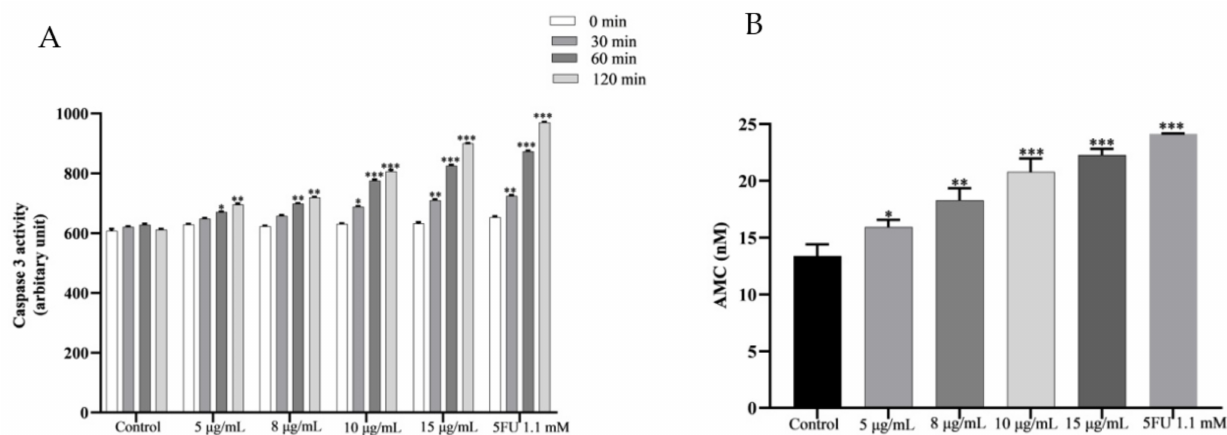
Figure 7. HCT-116 cells treated with PPE (5–15 µ g/mL) and 5FU 1.1 mM for 24 h were assayed for caspase 3 activity. ( A ) Increase in caspase 3 activity with time at increasing PPE concentration comparable to 5FU; ( B ) AMC concentrations at increasing PPE concentrations or with 5FU 1.1 mM (120 min). The values indicate ± SD ( n = 3); * p < 0.05, ** p < 0.01, and *** p < 0.001 vs. control.